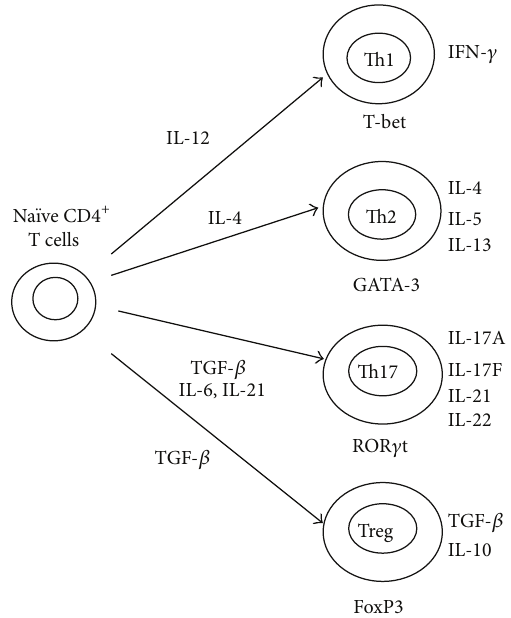
Figure 1: Differentiation pathways of na¨ıve CD4 + T cells under dif- ferent stimulation conditions. Na¨ıve CD4 + T cells can differentiate into different subsets depending on the cytokine milieu. Each subset is characterized by the unique expression of transcription factors and secretion of